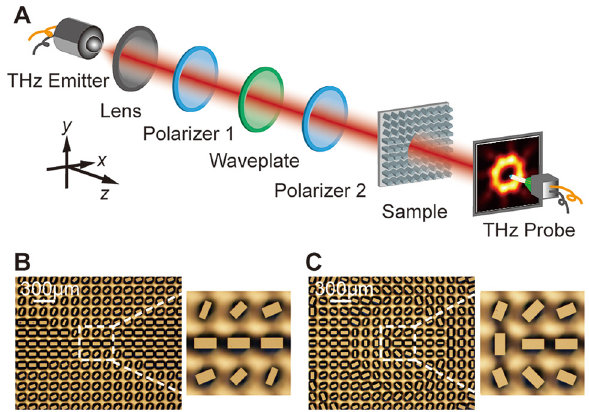
Figure 3: Schematic of the experimental setup and microscope images of the two fabricated metasurfaces. (A) The experimental setup. (B) Microscope image of the center part of the fabricated metasurface VVB generator. (C) Microscope image of the center part of the fabricated metasurface VBB generator. Both the inset scale barsrepresent300 μ m.Theirrightinsetsshowtheenlargedviewsof the middle nine